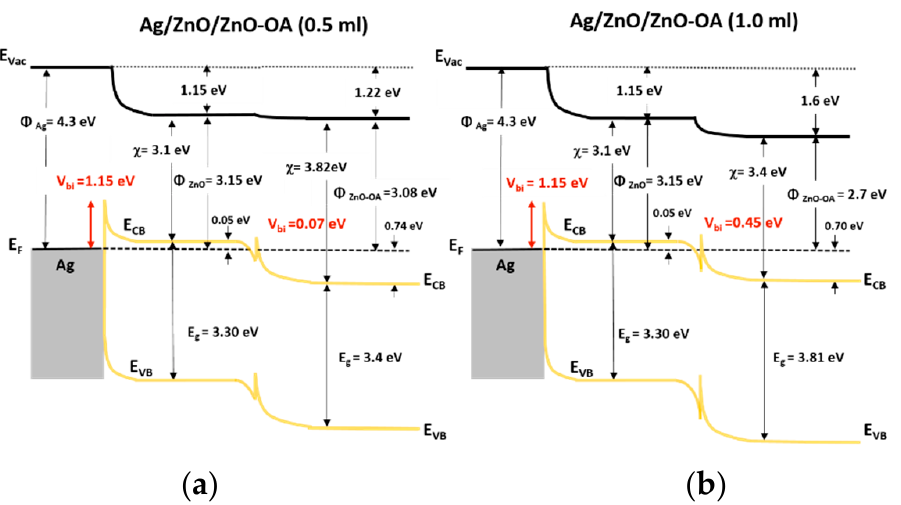
Figure 15. Induced built-in potential ( V bi ) at the interfaces of ( a ) Ag/ZnO-OA (0.5 mL)/ZnO QDs and ( b ) Ag/ZnO-OA (1.0 mL)/ZnO